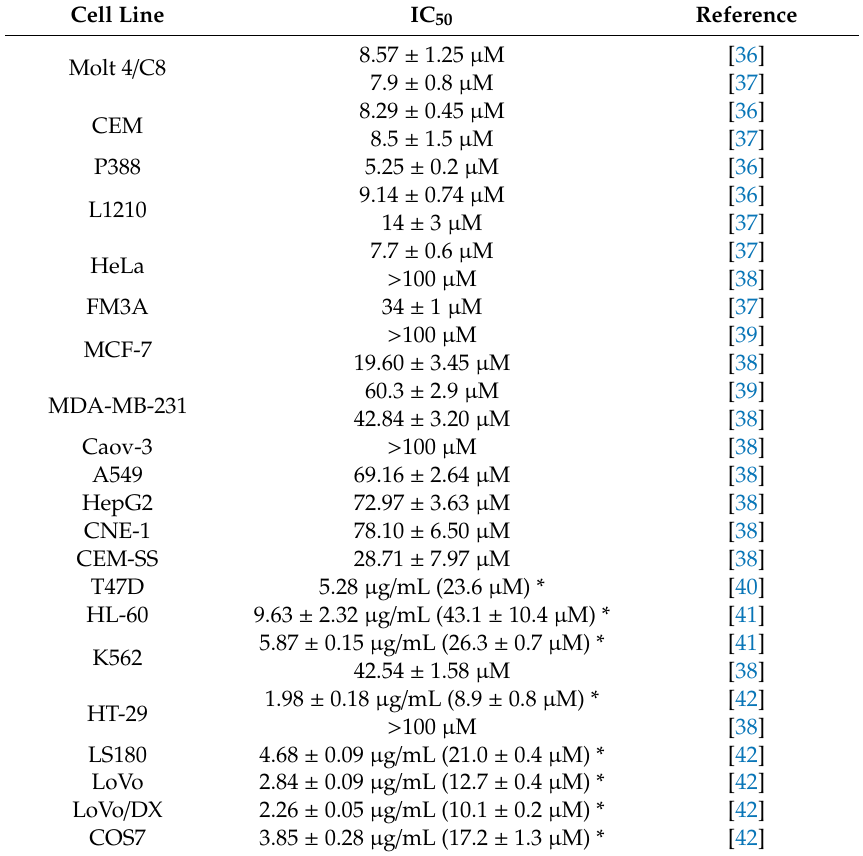
cancer cell lines show the potency of compound 1 against cancer cells. Novilla et al. [41] have